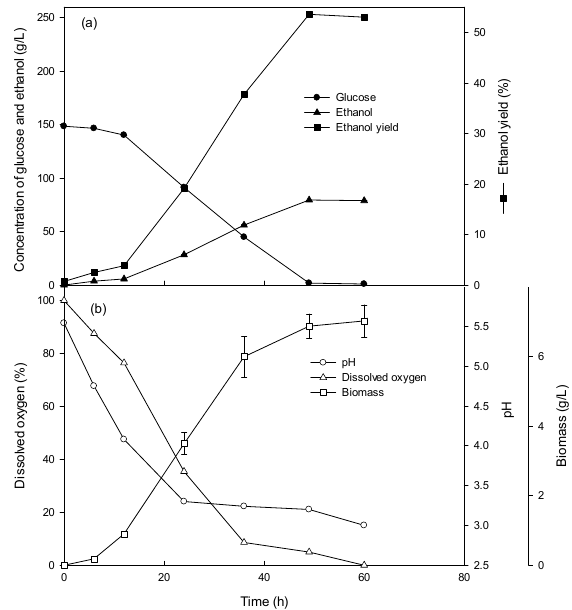
Figure 3. Time course of ( a ) glucose, ethanol concentration, and ethanol yield change, ( b ) dissolved oxygen, pH, and biomass in the batch cultures of S. cerevisiae BCRC 21812. The initial glucose concentration was 15% ( w / v ).